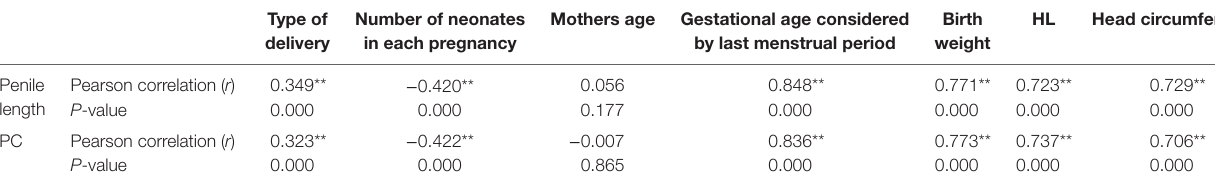
Type of number of neonates Mothers age gestational age considered delivery in each pregnancy by last menstrual period